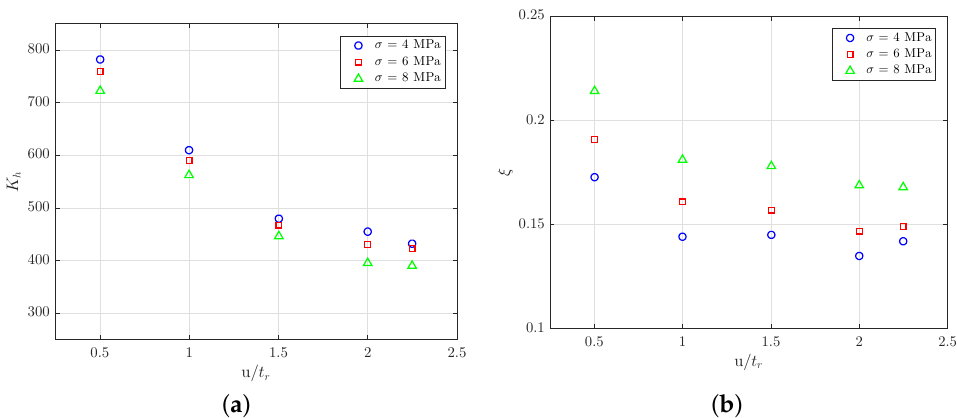
Figure 28. ( a ) Effective horizontal stiffness, k h , and ( b ) equivalent damping ratio, ξ , under different compression